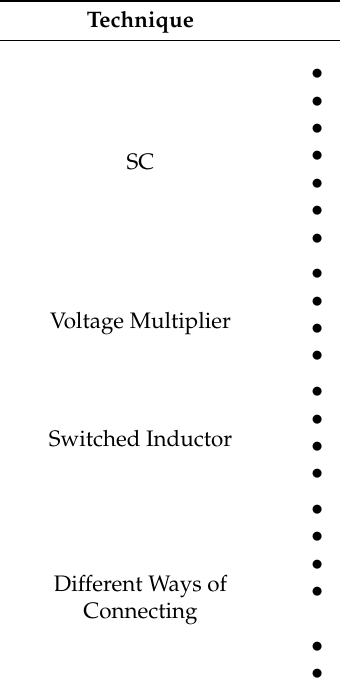
Figure 27. Multi-input step-up and step-down DC-DC converters. ( a ) [57]. ( b ) [59]. A summary of the techniques used in step-up and step-down DC–DC converters is provided in Table 6. Table 6. Summary of techniques used in step-up and step-down DC-DC converters.